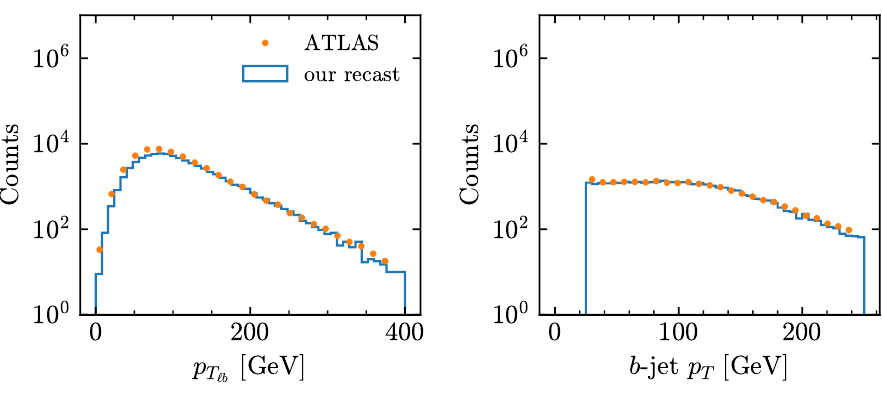
Figure 16 . Two validation plots are provided for the di-leptonic channel. The p T given in the left panel, and the b -jet p T distribution is given on the right, assuming m t = 172 : 5 GeV. The blue distributions correspond to our simulation and the orange dots represent the ATLAS results [14], which have been rescaled to so that the normalizations agree.